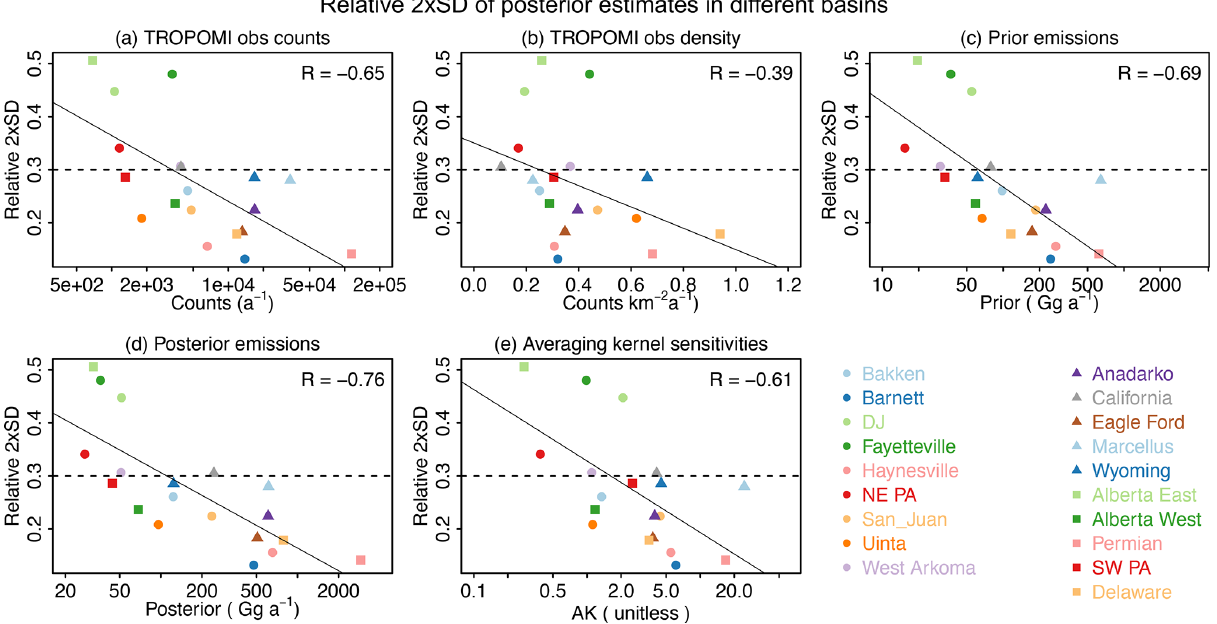
Figure 5. Relationship of the relative standard deviation (we use 2 σ here) of satellite-derived posterior estimates with different variables, including (a) the number of TROPOMI observations per year, (b) the satellite observation density, (c) prior emissions, (d) posterior emissions, and (e) averaging kernel sensitivities. The correlation coefficients are shown in the inset. The boundaries of the 19 O / G basins are overlain on the map, and the names of these basins can be found in Fig.